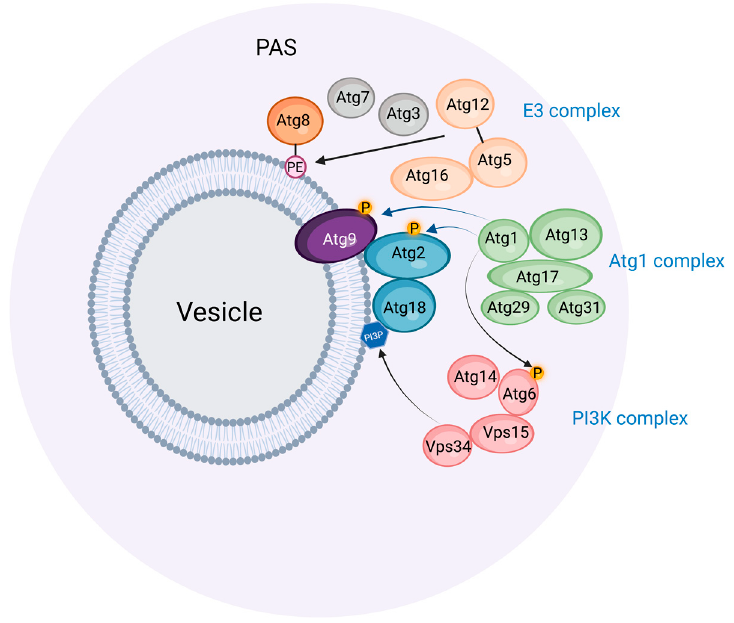
Figure 1. The preautophagosomal structure (PAS) in budding yeast. The PAS is thought to be a phase-separated molecular assembly, which associates with Atg9-containing vesicles. The Atg1 complex provides the scaffold for the PAS, and catalyzes the phosphorylation of Atg2, Atg9, and Atg6. The PI3K complex causes the formation of phosphatidylinositol 3-phosphate (PI3P) in membranes associated with the PAS. The E3 complex mediates the conjugation of Atg8 with phosphatidylethanolamine (PE) in conjunction with the E1 enzyme Atg7 and the E2 enzyme Atg3. Prepared with BioRender (www.biorender.com) and accessed on 15 February 2023.